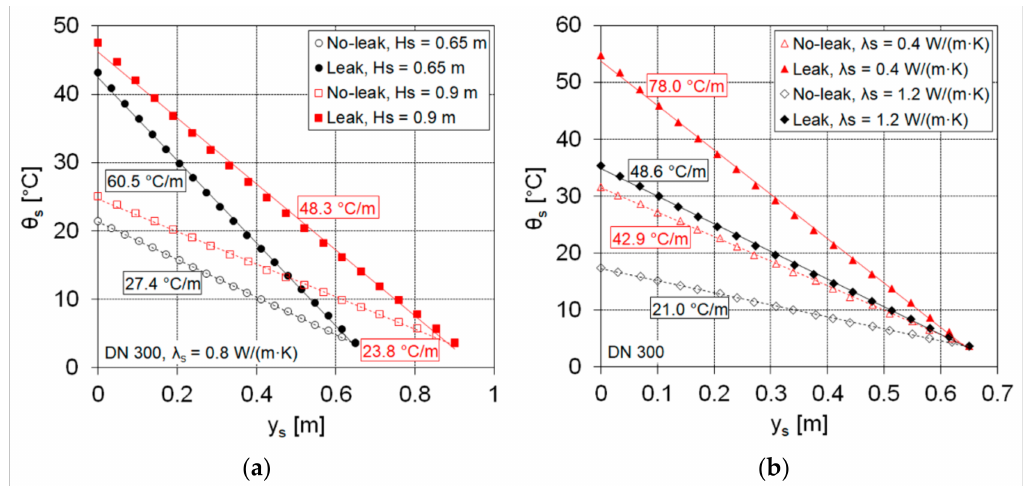
Figure 4. ( a ) Influence of the soil height above the channel ( H s = 0.65 m and H s = 0.9 m refer to Simulation Cases 5 and 6, respectively) and ( b ) influence of the soil thermal conductivity ( λ s = 0.4 W/(m · K) and λ s = 1.2 W/(m · K) refer to Simulation Cases 7 and 8, respectively).